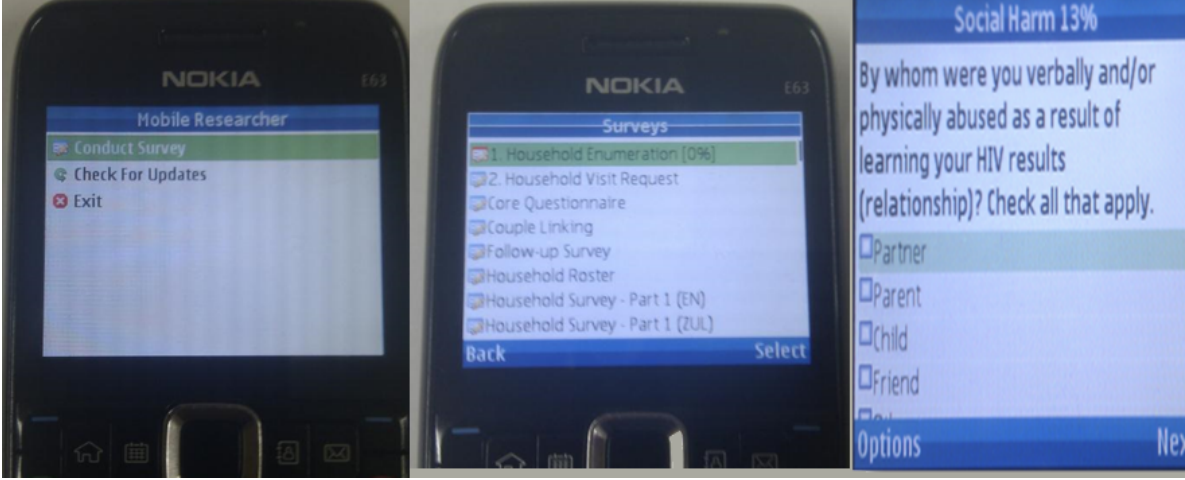
Figure 1. Example of the Mobenzi Researcher application running on a Nokia handset.